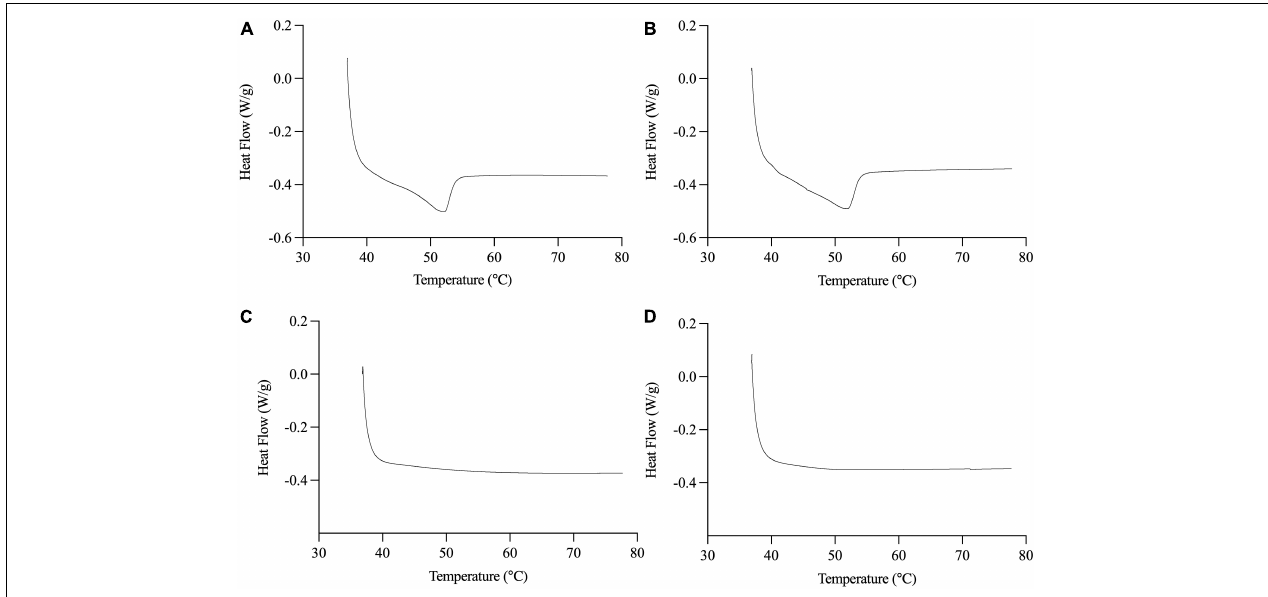
FIGURE 1 | Representative DSC thermograms of melting behavior of SS (A) , SU (B) , LS (C) , and LU (D) . Data reported as mean ± SEM, n = 3. LS, liquid lipid-acid stable emulsifier; LU, liquid lipid-acid unstable emulsifier; SS, solid lipid-acid stable emulsifier; SU, solid lipid-acid unstable emulsifier.